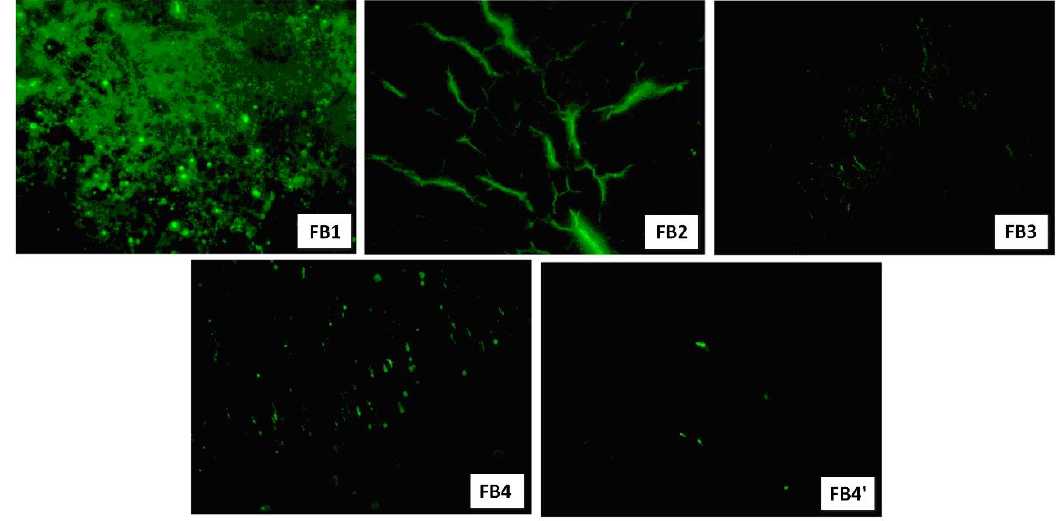
Figure 6. Adhesion of the GFP protein on the surface of the films FB1 – FB4 and FB4 ′ . Fluorescent microscopy, magnification of 400×.